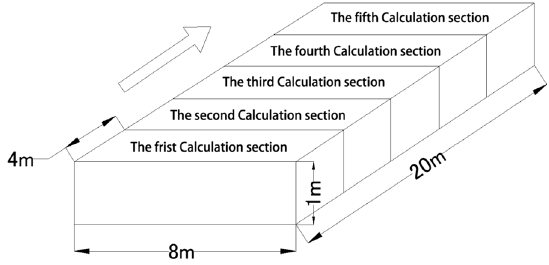
Fig. 6 Test design of field filling